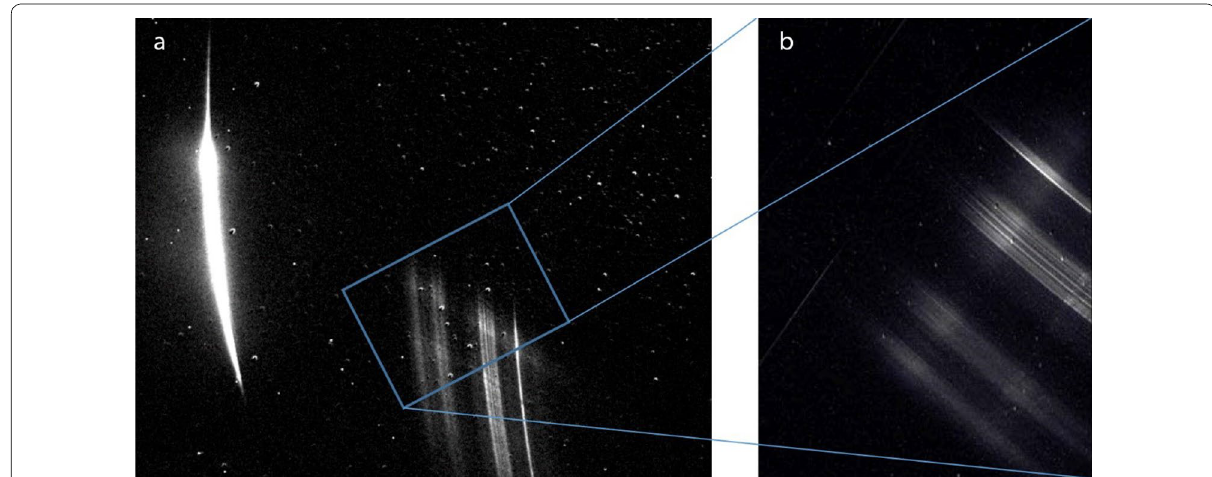
Fig. 3 M20160930_213851 fireball spectrum images obtained simultaneously with the two spectrographs described in this article. a Image obtained with spectrograph #1, showing the real image of the fireball across the stars (left) and the spectrum itself (lower centre) and extracted in Fig. 4. b Image obtained with spectrograph #2, showing the same spectrum, but with higher spectral